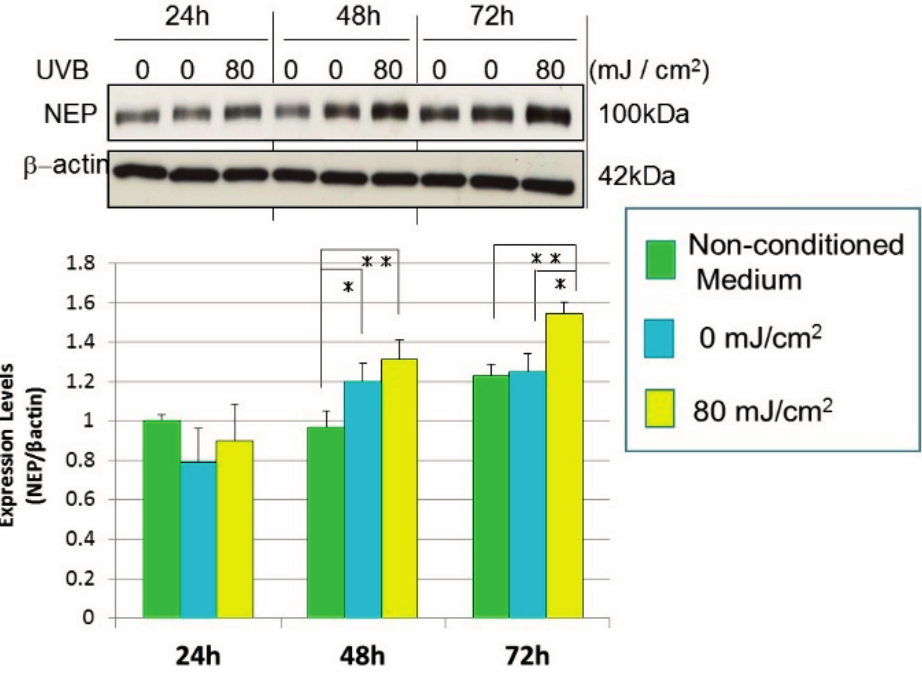
Figure 4. Effects of conditioned medium from UVB-exposed human primary keratinocytes on neprilysin/NEP protein in human fibroblasts. Neprilysin protein levels were measured by Western blotting analysis 24, 48 and 72 h after the addition of conditioned medium (CM) from UVB (0 or 80 mJ/cm 2 )-exposed HPKs or non-conditioned fresh DMEM medium (NCM) at a 1:1 dilution to human fibroblasts. Representative immunoblots from three independent experiments are shown. Values are means ± S.D. derived from the three independent experiments. * p < 0.05, ** p <